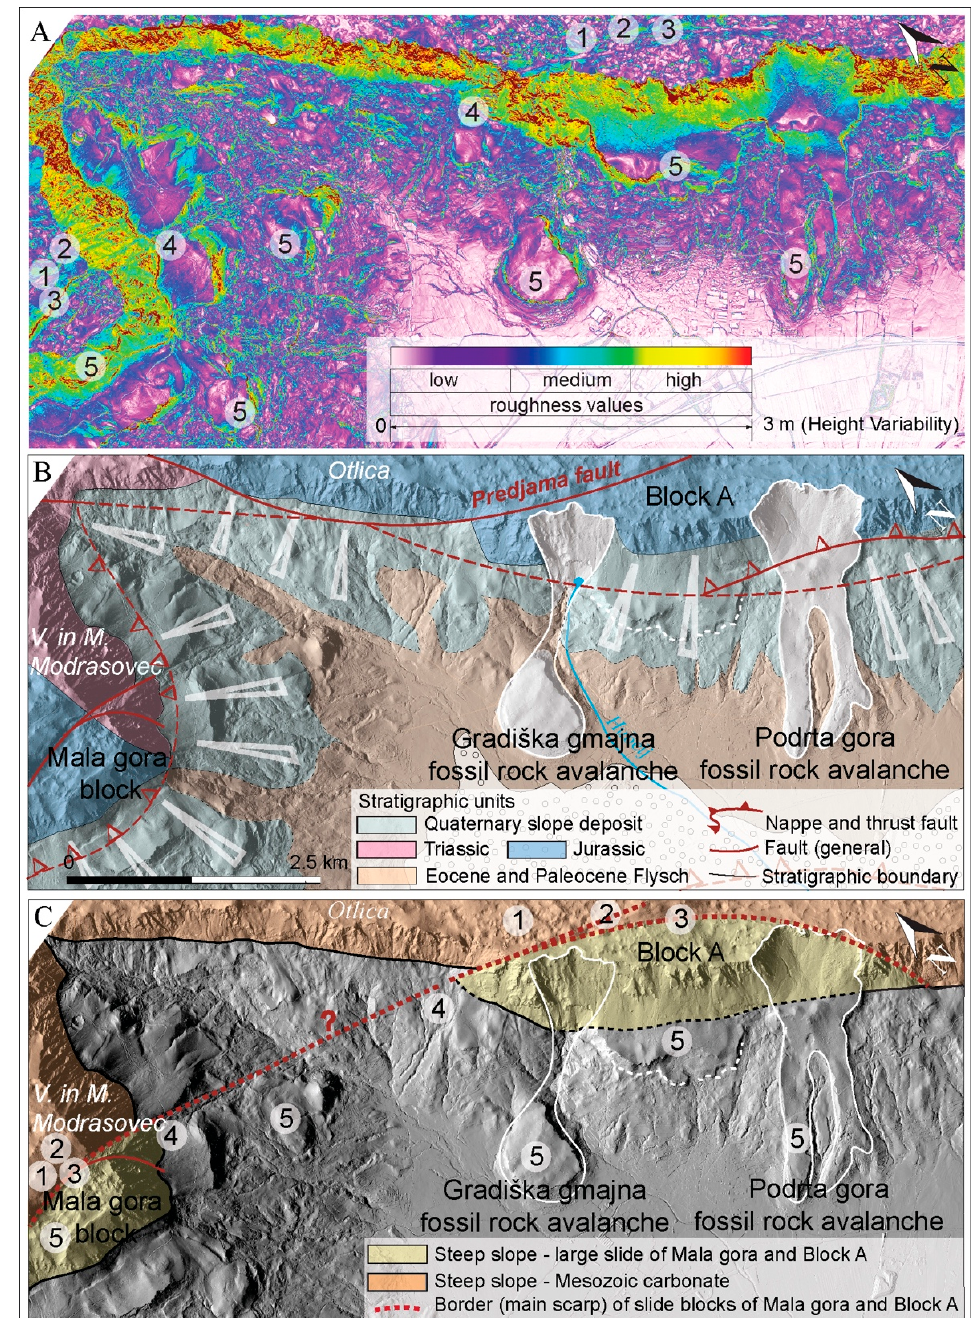
Figure 7. Interpretation of the processes in the area around Ajdovš č ina, where the whole area (Block A) above the hinterland of the fossil rock avalanche of Gradiška gmajna and Podrta gora could be classified as part of a large slide block by analogy with Mala gora. ( A ) HV map, ( B ) geological map, and ( C ) map with individual geomorphometric elements marked: 1 = linear distribution of change in the degree of HV along the northern branch of the Predjama fault is comparable to the main scarp of Mala gora; 2 = areas north to northeast of both lines have greater HV than southwestern areas; 3 = arcuate curvature of lines; 4 = southwestern carbonate massifs in the concave part of the lines, which are subsided; 5 = slopes below the concave margin where recent and sub-recent gravitational processes are intense.